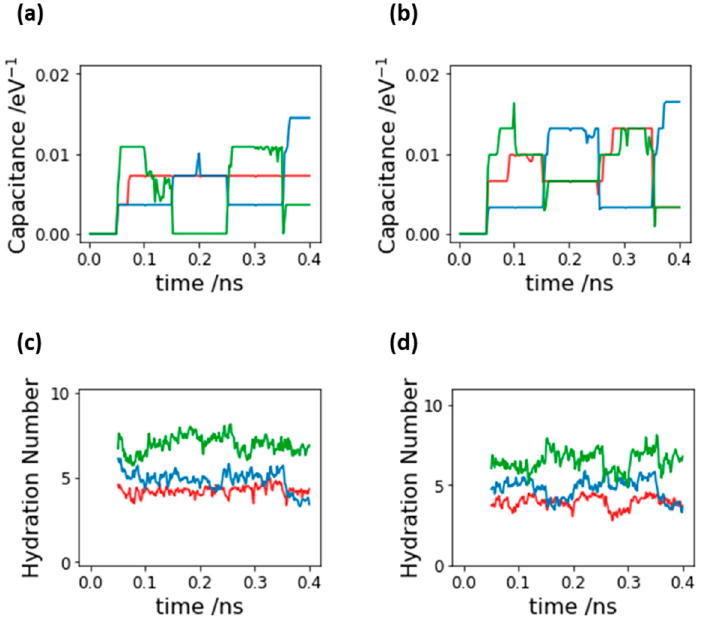
Figure 8. Capacitance changes on the graphene electrodes for ( a ) single-layer graphene and ( b ) bilayer graphene. Hydration numbers of ions for ( c ) single-layer graphene and ( d ) and bilayer graphene. Li, Na, and K ions are represented by red, blue, and green curves, respectively.